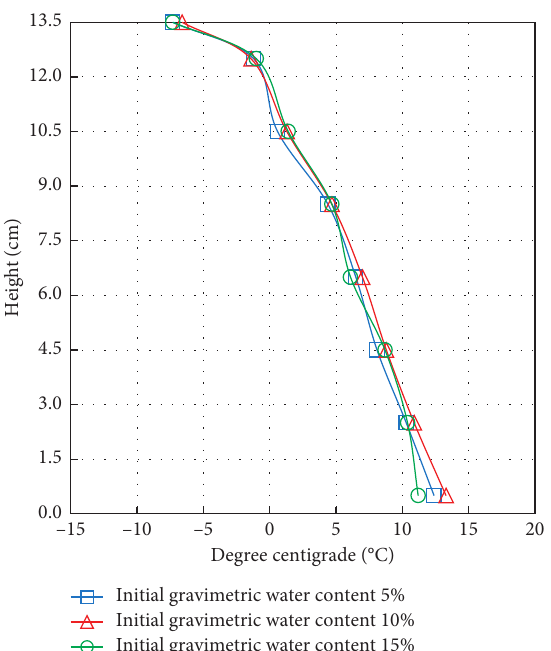
Figure 11: Measured temperature distribution of different initial water